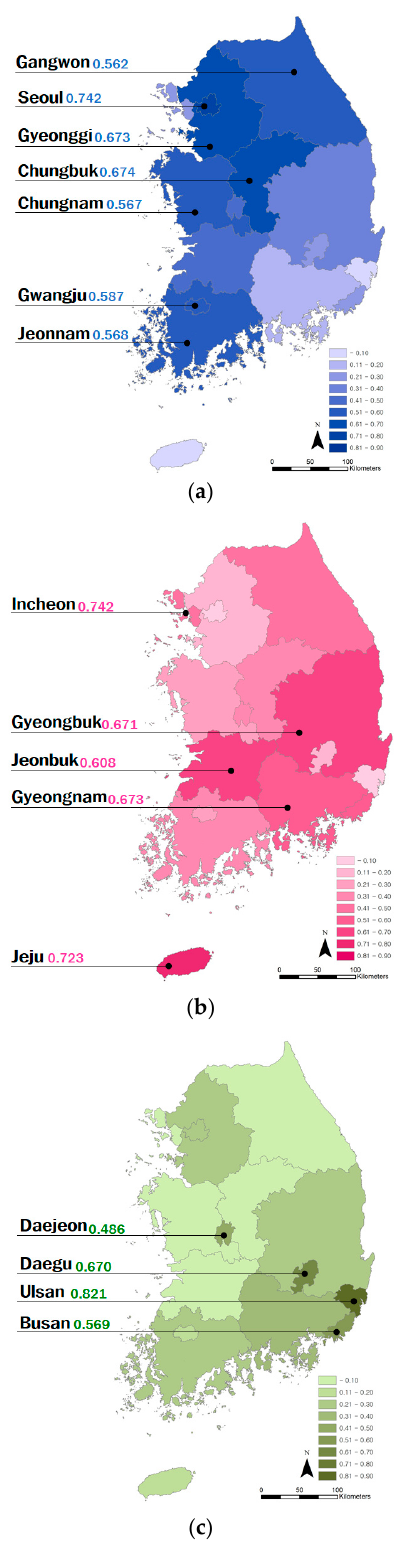
Figure 2. Maps of environmental conflicts for ( a ) areas sensitive to the characteristic of “atmosphere”, ( b ) areas sensitive to the characteristic of “development”, and ( c ) areas sensitive to the characteristic of